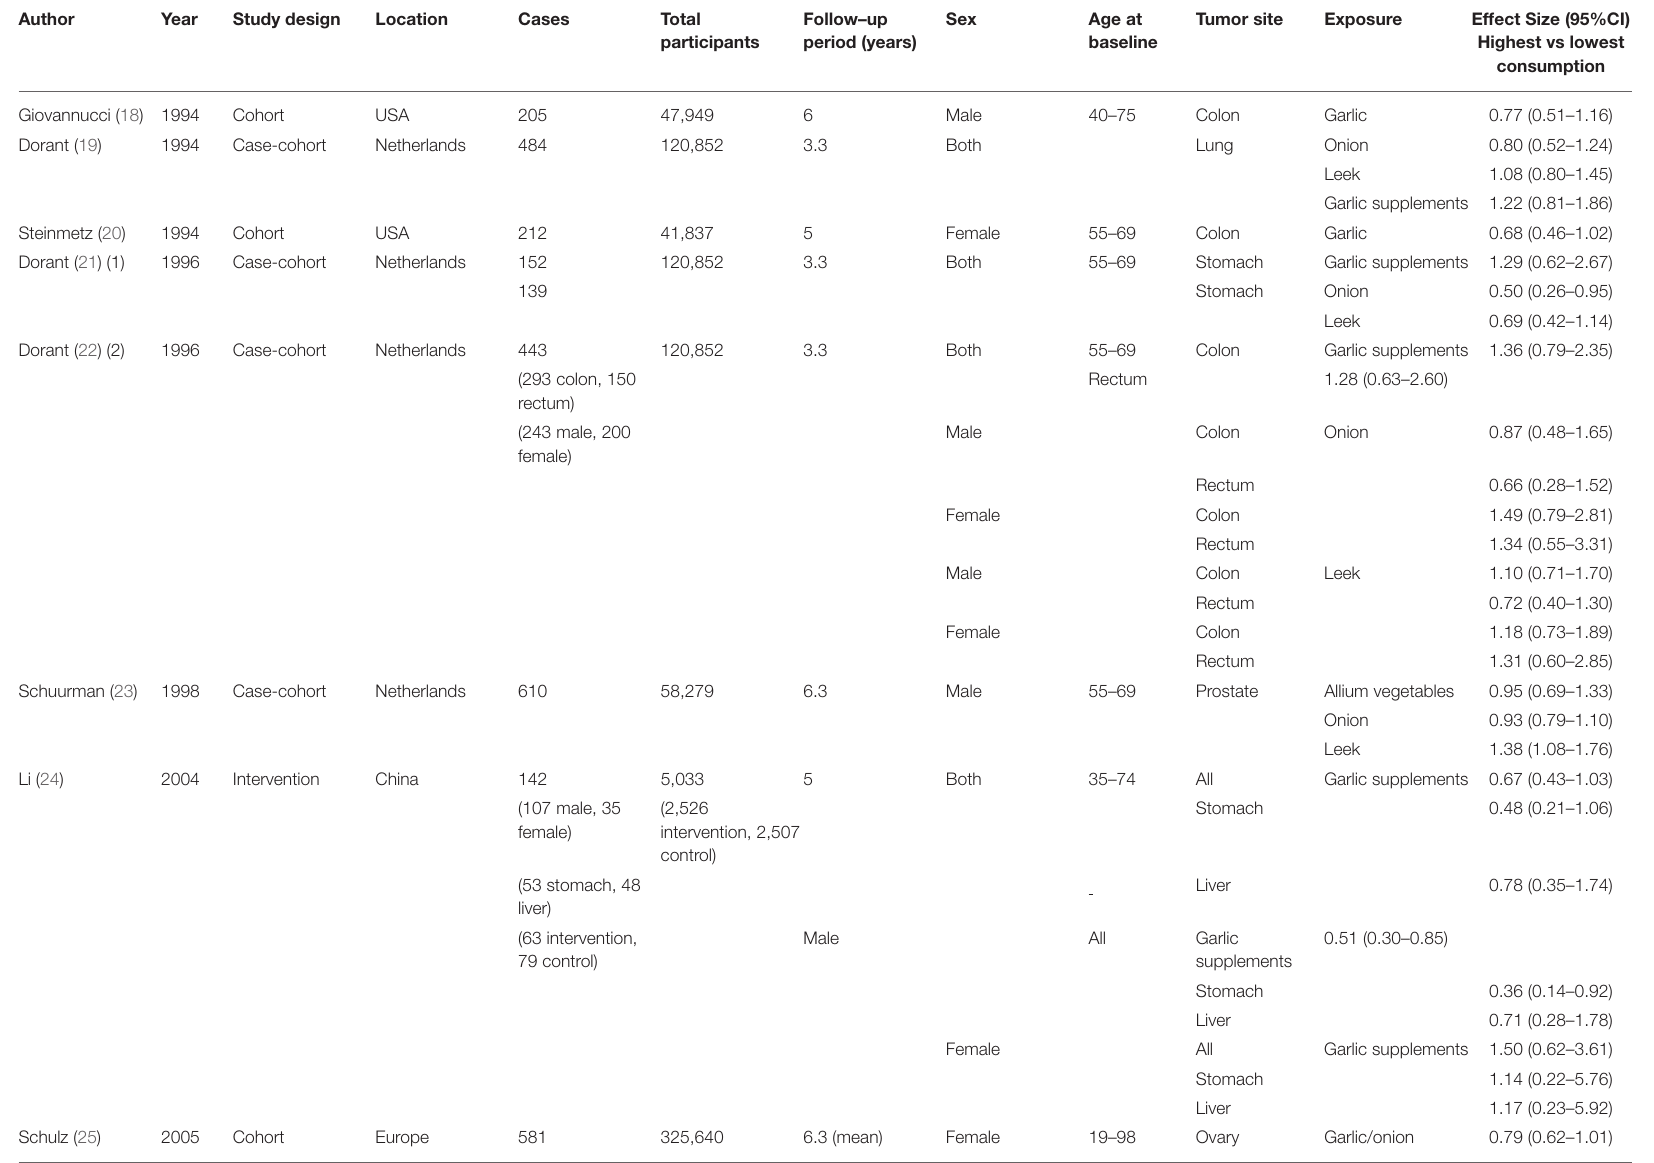
TABLE 1 | Characteristics of studies included in the